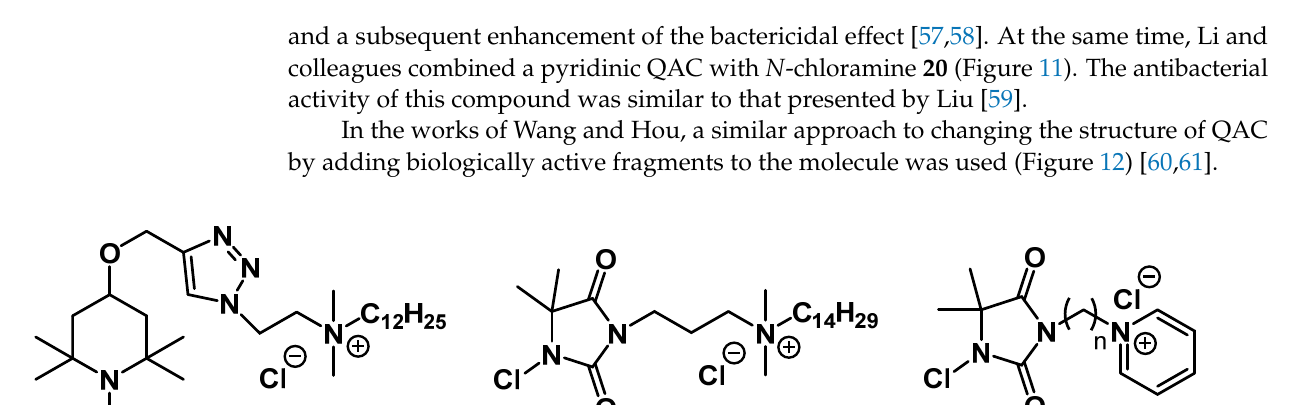
Figure 10. Mono-QACs containing hydrazide bridges.